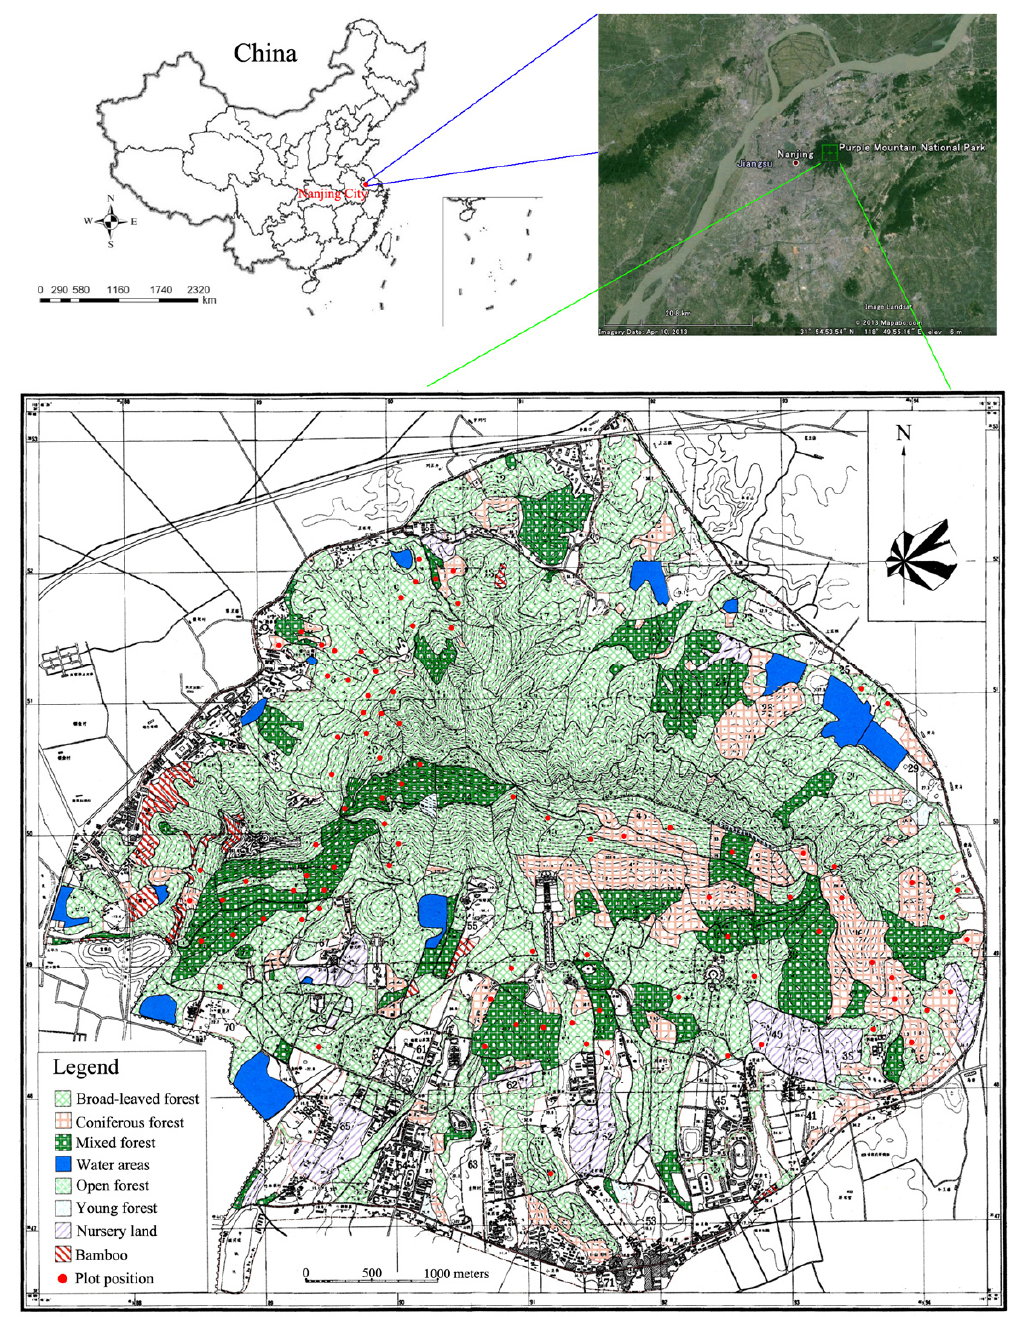
Figure 1. Location map of the study area with vegetation types in 2002 and the plot positions investigated in September, 2011. The location map was cited from Google Earth, and the vegetation map was from the ArcGIS (GIS, Geographic Information System) database established in